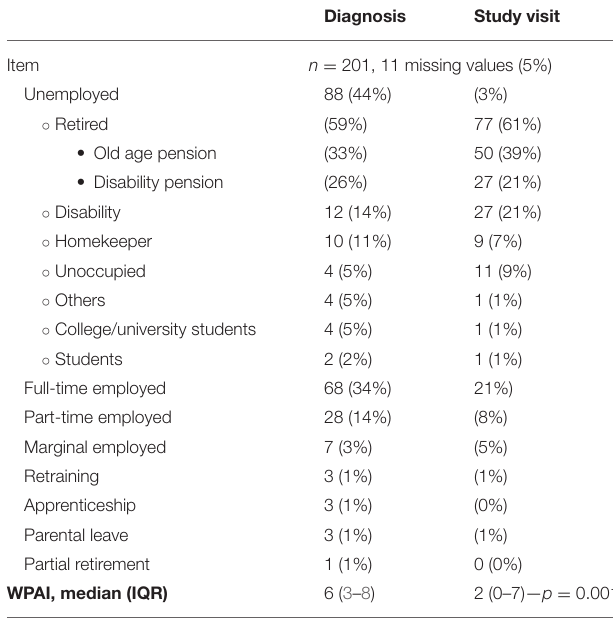
TABLE 2 | Change of employment and work productivity from diagnosis to study